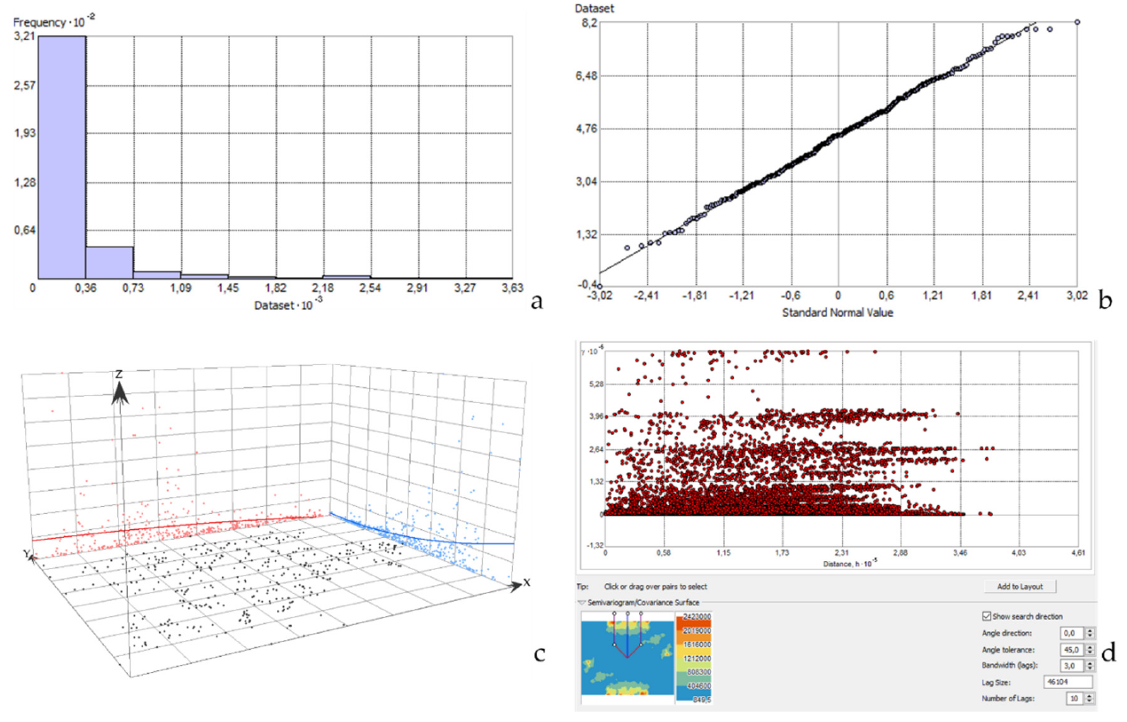
Table 2. Statistical analysis of activity concentration of the main natural radionuclides and radioactivity parameters in the interconnected groundwaters of Castilla y León.